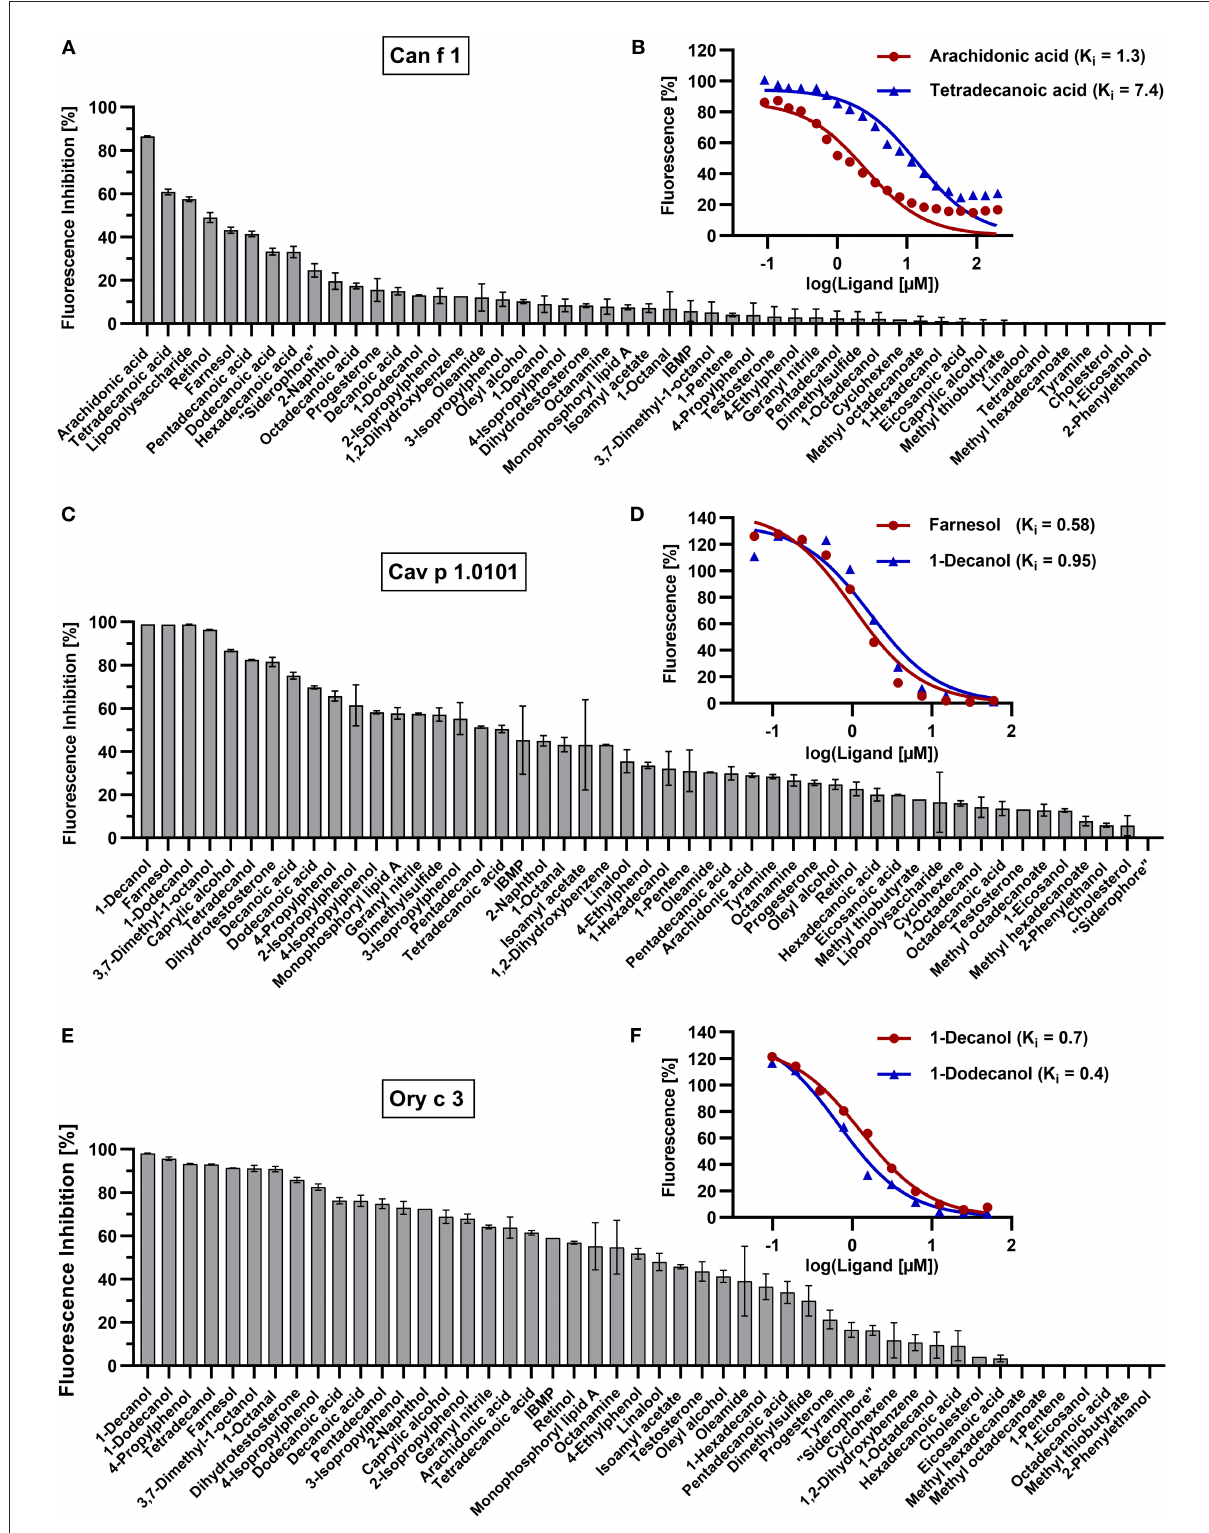
FIGURE6 Competition assays with selected allergen-fluorochrome complexes and forty-nine ligands. Mean fluorescence inhibition of 5 µ M allergen-fluorochrome complexes by 50 µ M competitive ligands in percent ( n = 2) for (A) Can f 1 (C) Cav p 1.0101 and (E) Ory c 3. Dissociation constants (K i ) of most effective ligands were calculated by non-linear regression of logarithmized dose-dependent titration curves with (B) 0–100 µ M arachidonic acid and tetradecanoic acid for Can f 1, (D) 0–60 µ M farnesol and 1-decanol for Cav p 1.0101, (F) 0–50 µ M 1-dodecanol and 1-decanol for Ory c